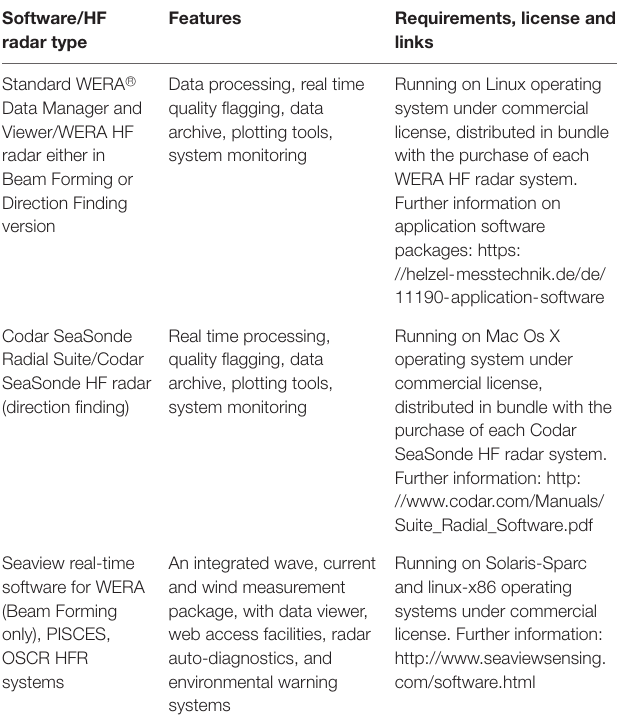
TABLE 7 | Processing levels for HF radar data. TABLE 8 | Software for data acquisition and pre-processing.